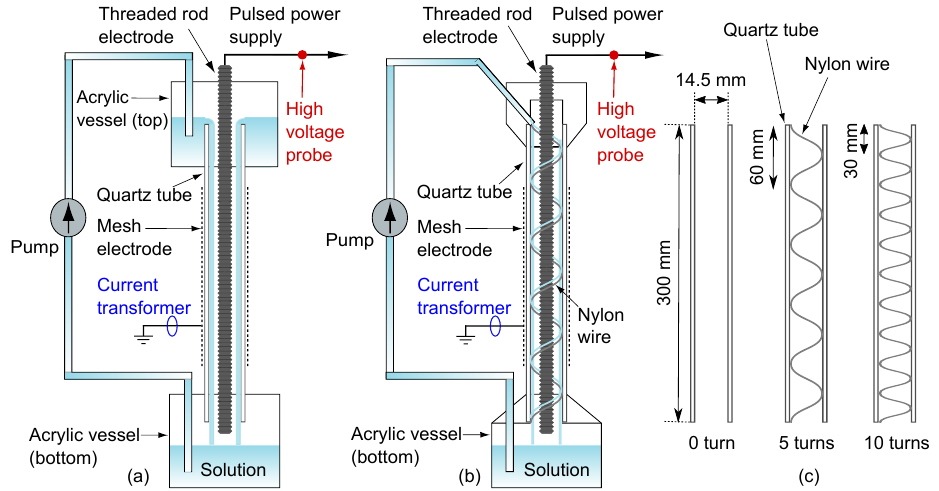
Figure 1. Schematics of coaxial cylindrical plasma reactors. ( a ) Overflow-type reactor. ( b ) Swirling- flow-type reactor. ( c ) Arrangement of nylon